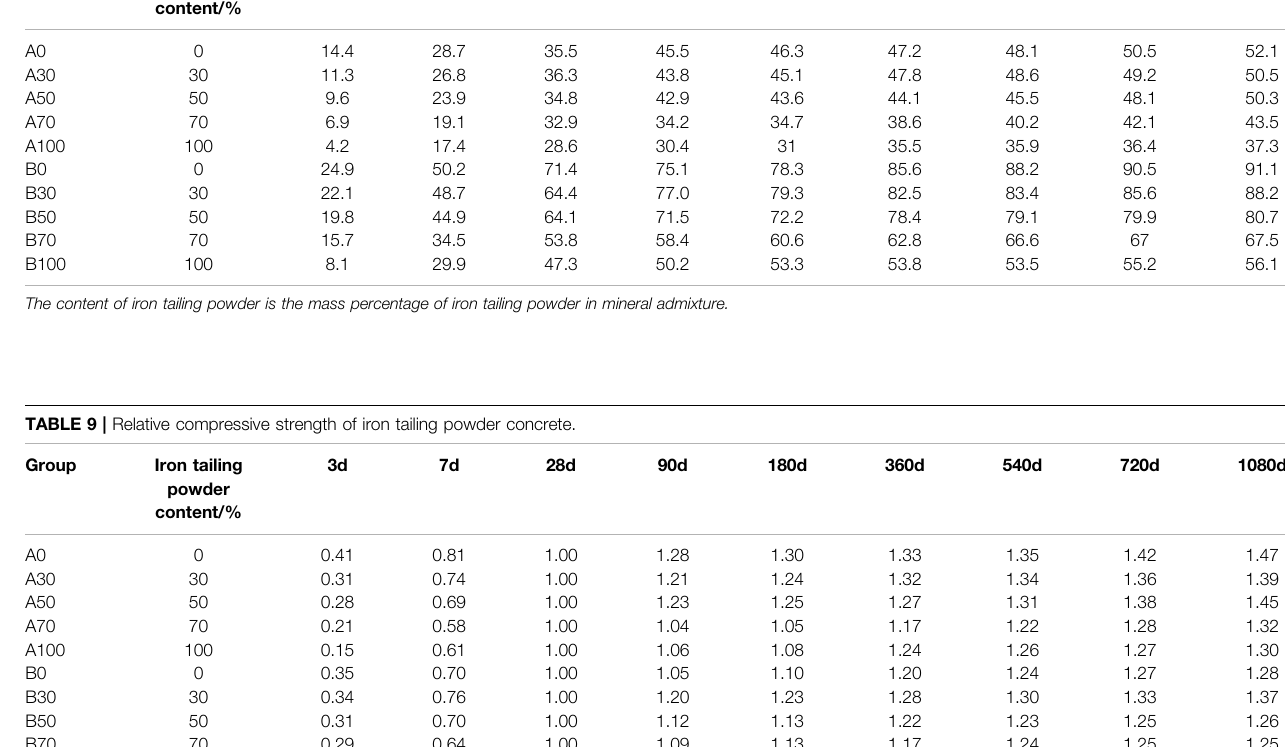
TABLE 8 | Compressive strength of iron tailings powder concrete (MPa). Group